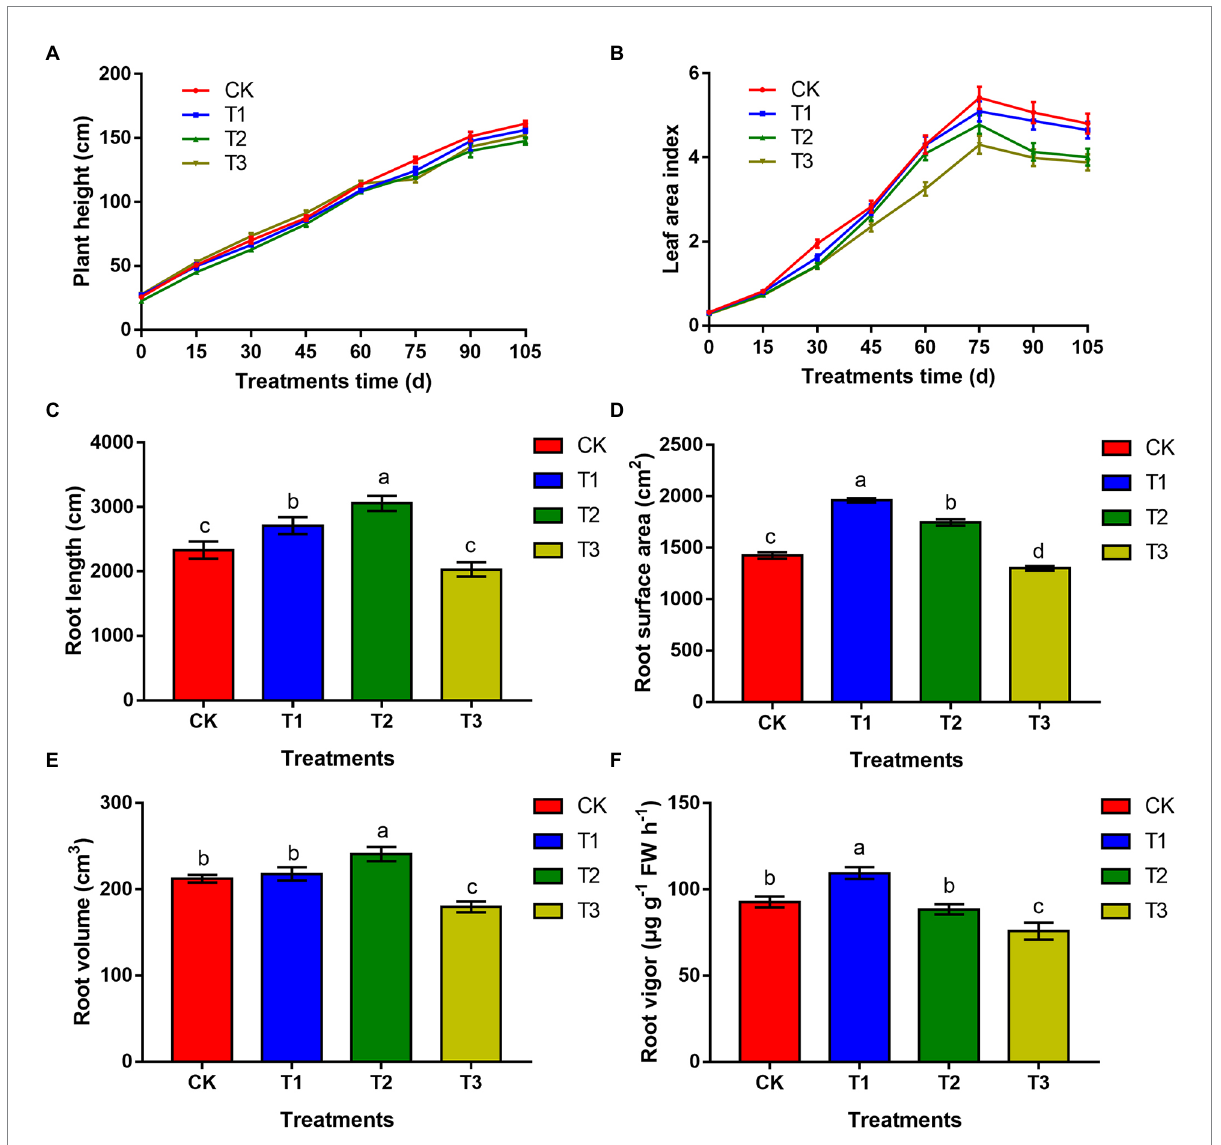
FIGURE 1 The effects of different irrigation amounts on plant height (A) , leaf area index (B) , root length (C) , root area (D) , root volume (E) , and root vigour (F) . n ≥ 3; different letters indicate significant differences ( p < 0.05).